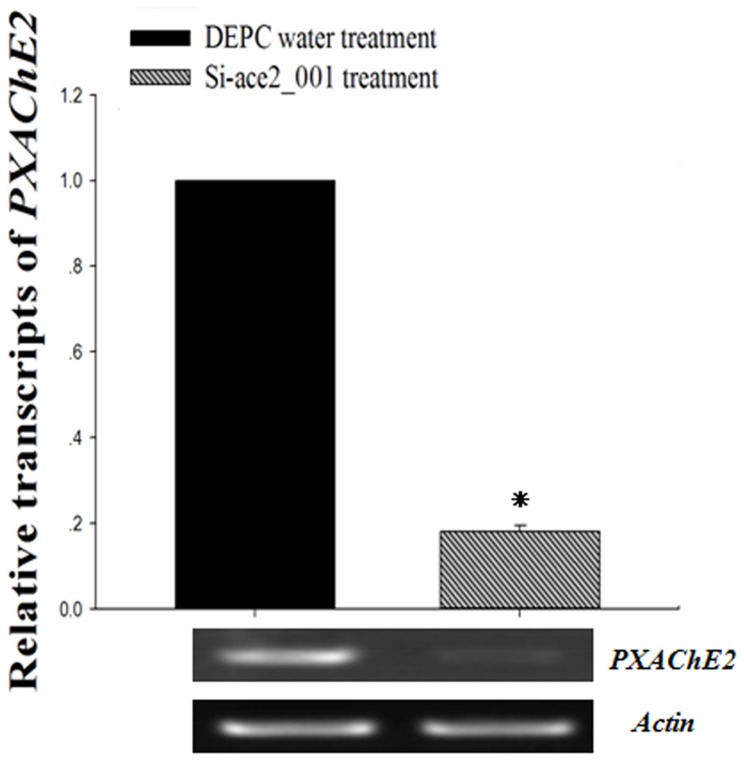
Real-time PCR data were normalized to the expression of PxAchE2 in the samples treated with Si-ace2_001 or DEPC water as shown by RT-PCR gel pictures at the bottom of each panel.Each point represents the mean±SEM from three independent experiments and asterisk means significant differences (P<0.05) between the two groups.